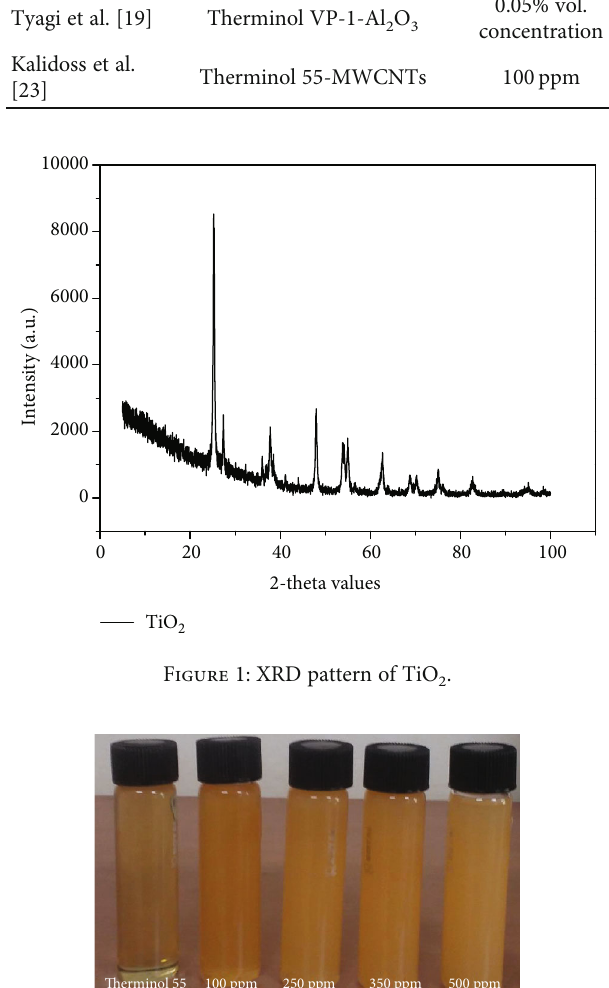
Figure 2: Photographic view of Therminol 55-TiO